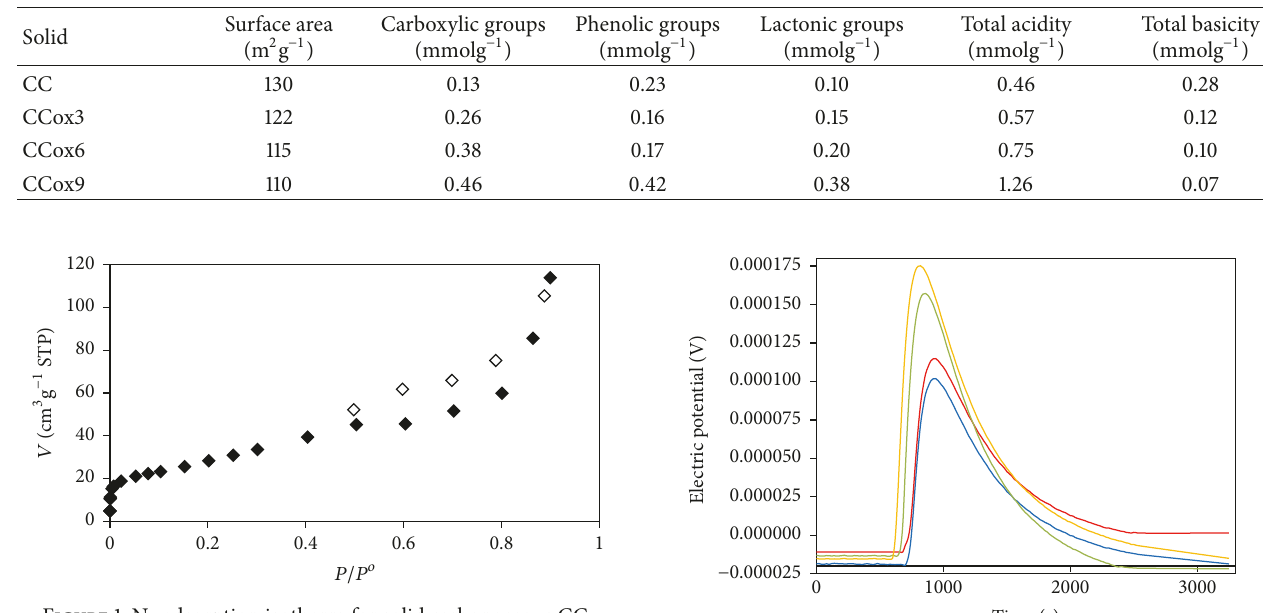
Figure 1: N 2 adsorption isotherm for solid carbonaceous CC.